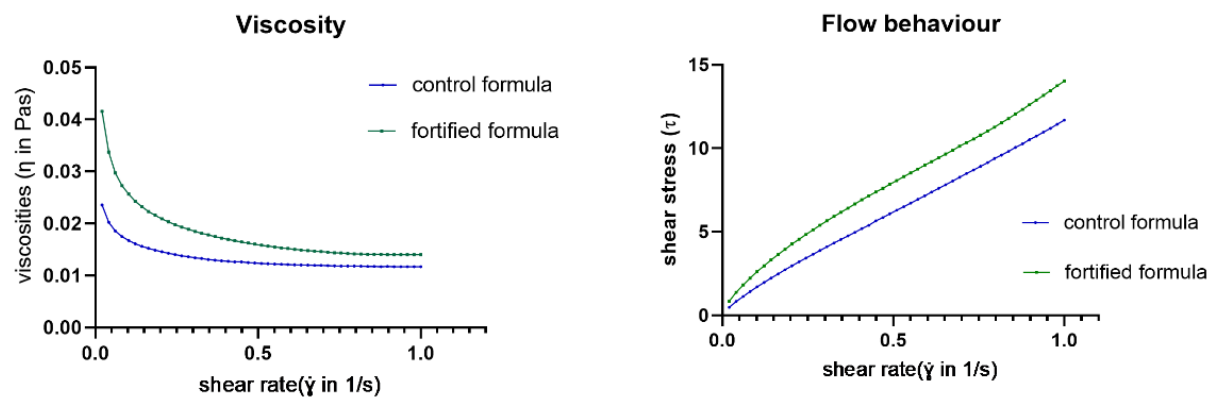
Figure 1. Viscosity and flow curves of retorted control and fortified formulas at different shear rates. The lines represent the corresponding power of increased shear rate. Table 4. Comparison of viscosity and flow behavior in the control and fortified complete nutrition formulas after retort sterilization at different time points.